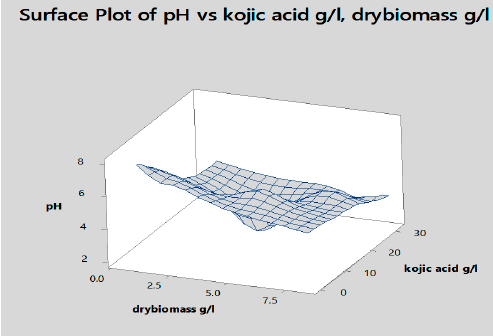
Fig. 6. Effect of pH on kojic acid synthesis, drymass and consumption of sugar by